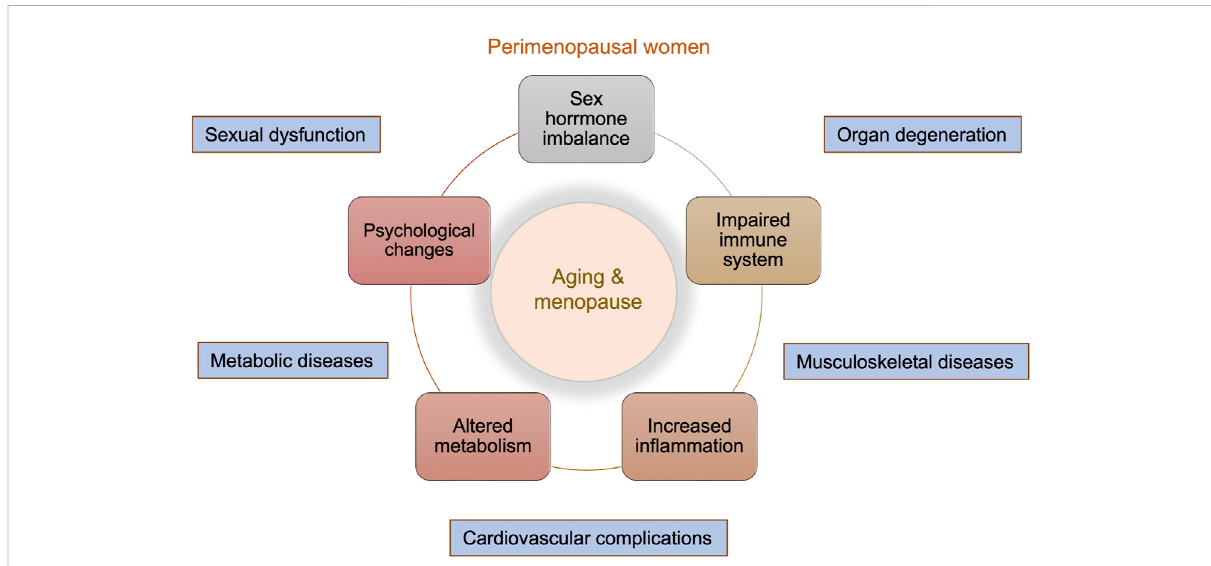
FIGURE 1 Overviewofphysicalandemotionalchangesinperimenopausalwomen.Menopauseisanaturalagingprocessandmarksenormouschangesin both the general and sexual life of women. These include sex hormone imbalance, impaired immune system, increased in fl ammation, altered metabolism, and psychological changes. These changes can lead to accelerated organ degeneration and increased risks of musculoskeletal diseases, cardiovascular complications, metabolic diseases, and sexual